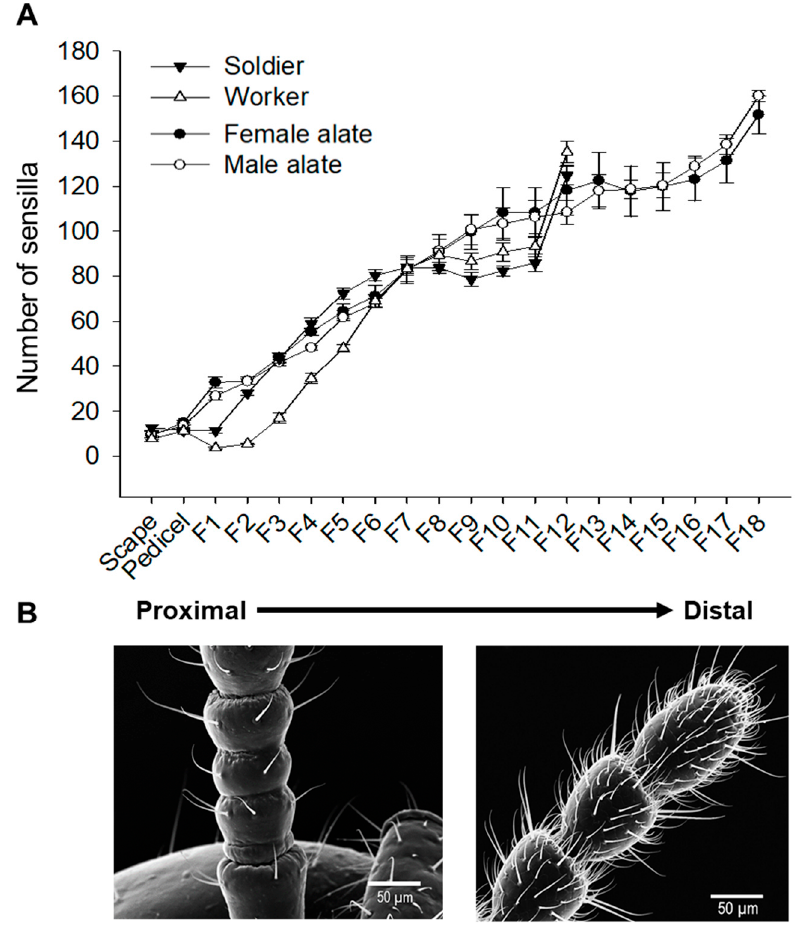
Figure 4. Distribution of total sensilla along the antennae in C. formosanus castes. ( A ) Ventral side abundance of sensilla per antennal segment. F1-F18 denote flagellomeres numbered from proximal to distal end. All alate samples analyzed here had 18 flagellomeres, while worker and soldier samples had 12 flagellomeres. Data are presented as mean ± SE ( n = 12 for soldiers and workers, n = 9 for female and male alates). ( B ) A worker antenna representing the distribution of sensilla at the distal and proximal ends.